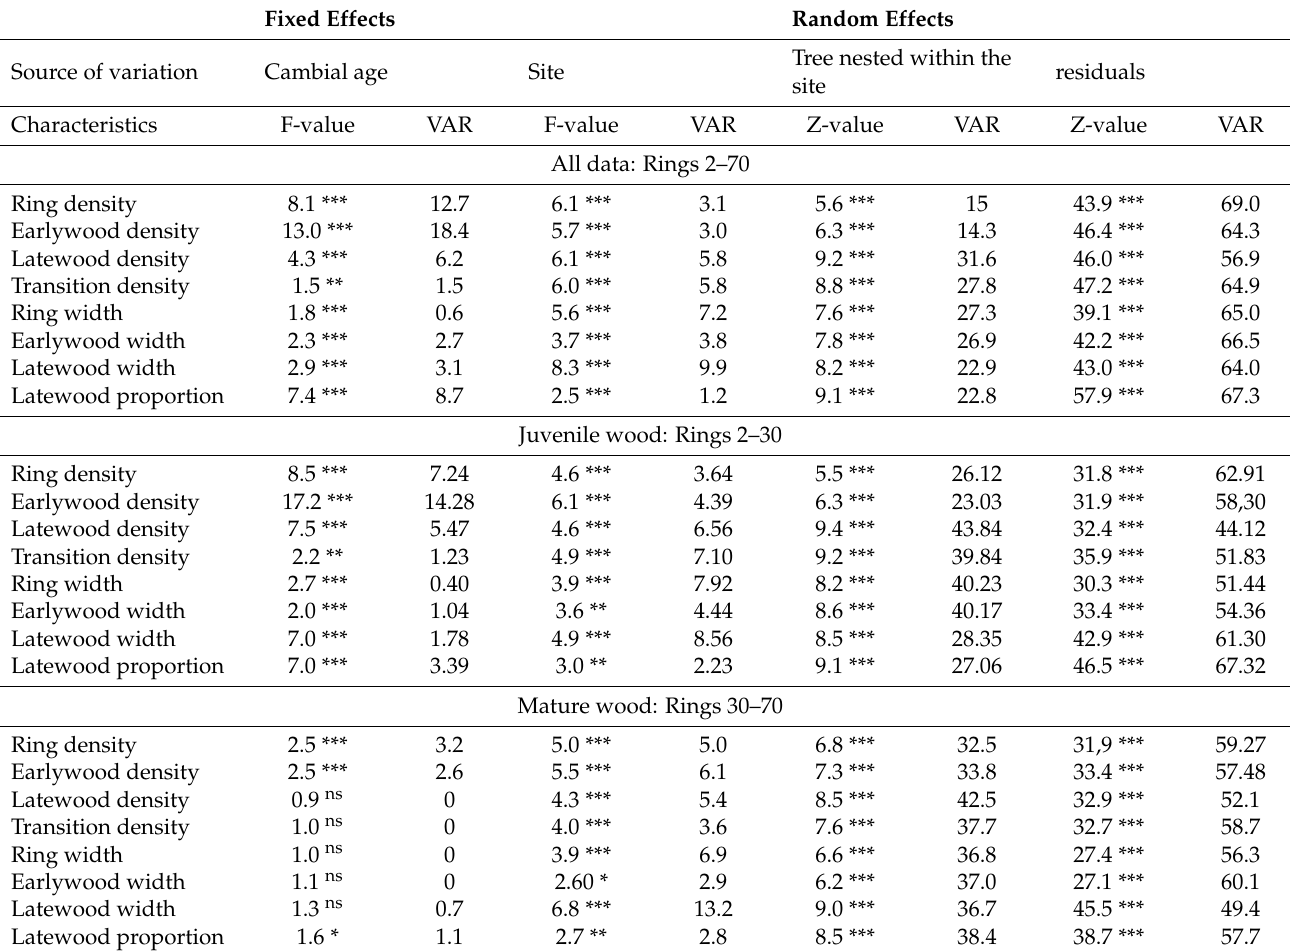
Table 4. Linear mixed model analysis of variance, with F-value for fixed effects, Z-value for random effects and their significance for each source of variation, and variance components (VAR) for wood density components and ring widths in Thuja occidentalis